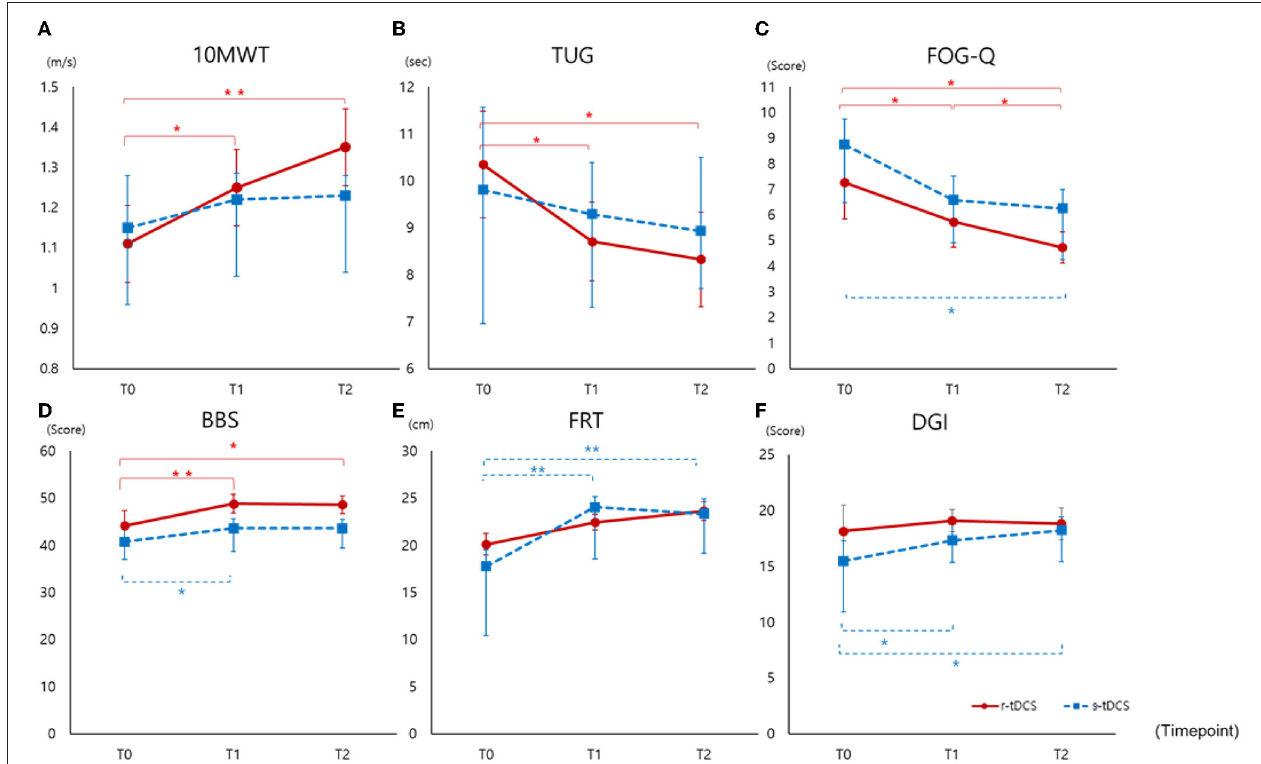
FIGURE 2 | Outcomes measured before intervention (T0), immediately after intervention (T1), and at 4 weeks after completion of the intervention (T2) (A) 10MWT, (B) TUG, (C) FOG-Q, (D) BBS, (E) FRT, (F) DGI. 10MWT, 10-m walking test; TUG, Timed Up and Go Test; FRT, Functional Reach Test; FOG-Q, Freezing of Gait Questionnaire; BBS, Berg Balance Scale; DGI, Dynamic Gait Index; * p < 0.05, ** p <